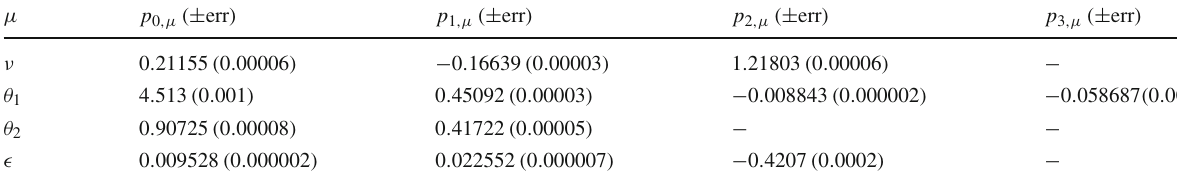
Fig. 4 Angular distribution of Cherenkov photons from a single gamma-ray (top) and proton (bottom) shower. CORSIKA simulations (filled histograms) are compared to the parametrized distributions (solid curves) at s = 0 . 8, 1 . 0, and 1 . 2 (indicated inside the plot). Predictions from Refs. [8,24,26] are shown for comparison (see legend). Curves of a common shower age are vertically displaced for better